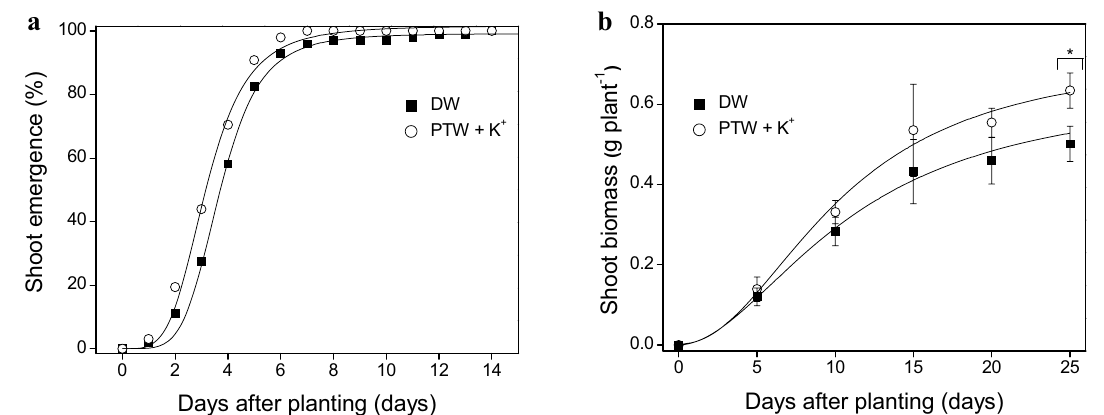
Figure 1. Shoot emergence ( a ) and shoot biomass ( b ) of Panax ginseng , each sprayed with deionized water (DW) and plasma-treated water (PTW) containing potassium ions (K + ) up to 25 days after planting. The shoot emergence was expressed as a percentage of the total number of emerged shoots out of 98 P. ginseng rhizomes. The shoot biomass was averaged from 14 P. ginseng shoots harvested for each sampling date. An asterisk indicates a significant difference between the DW and PTW + K + at each day ( P < 0.05).